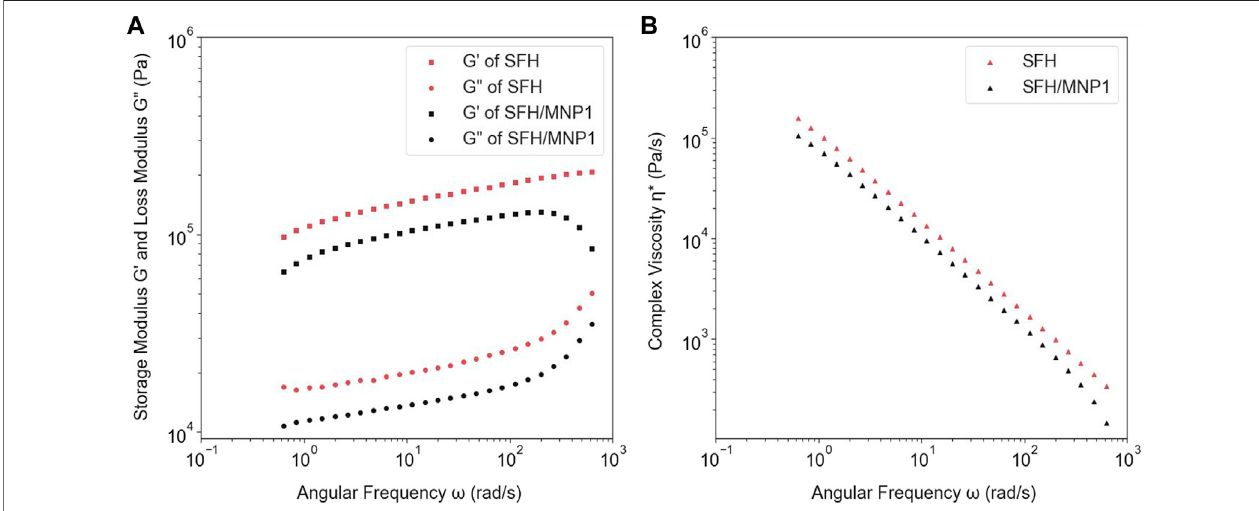
FIGURE3|(A) ThecomparisonbetweenthestorageandlossmodulusofSFH-DOXandSFH-DOX/MNP1. (B) ThechangesofcomplexviscosityofSFH-DOXand SFH-DOX/MNP1 during the different angular